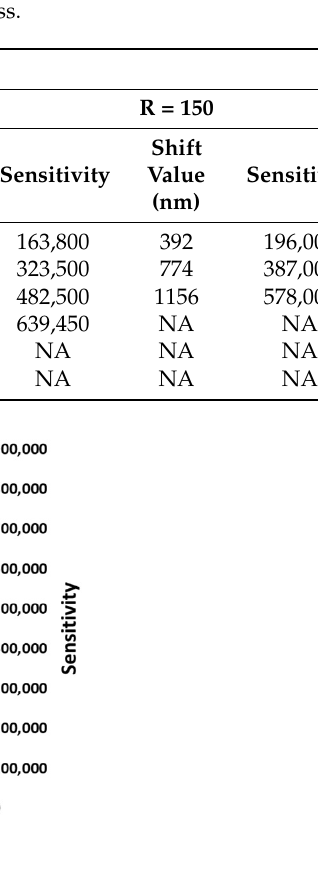
Figure 7. The comparison for the sensitivity and effective length between two propagation losses. Since the optical pulse width will affect the ring-down order number, the input light bandwidths from TDTM were changed from 132 nm, 26.2 nm, and 13.2 nm. The ring-down order for a 132 nm bandwidth under the same 100 µ m radius MRR and same pulse light with 22.86 µ W power at 1310 nm wavelength could be detected more. In Table 4, the sensitivity shows 642,000 nm/RIU. When the input light bandwidth is less than 132 nm, the waveform order can be sensed less, and the sensitivity is decreased, as shown in Figure 8. We can also conclude that the bandwidth does not affect the ring-down interferogram’s effective length. Table 4. The bandwidth effect on the spatial sensitivity in the ring-down based